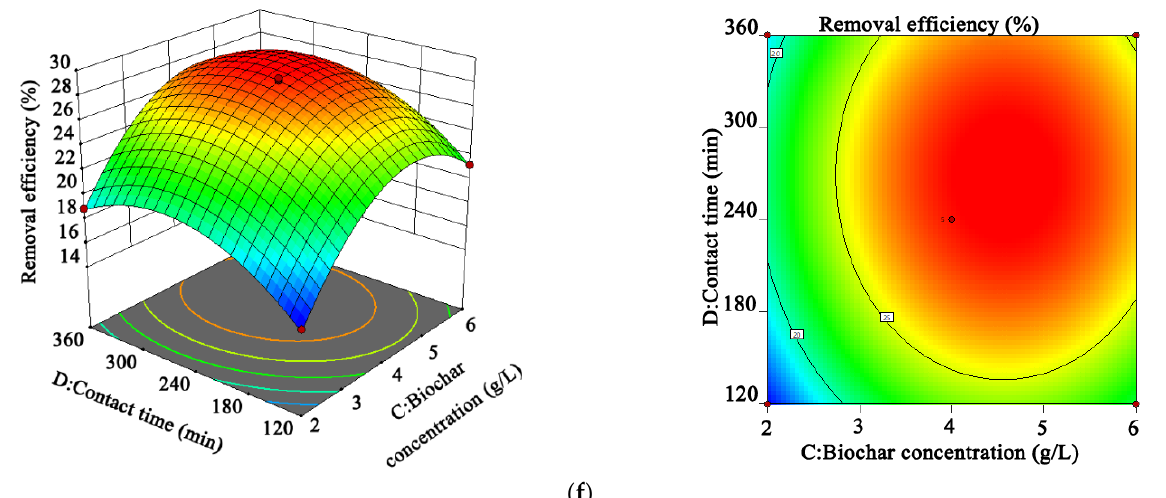
Figure 6. Contour plot and 3-D surface plot for Cr (VI) removal. ( a ) interaction between the Cr(VI) concentration and pH; ( b ) interaction between the Cr(VI) and biochar concentration; ( c ) interaction between Cr(VI) concentration and contact time; ( d ) interaction between pH and biochar concentration; ( e ) interaction between pH and contact time; ( f ) interaction between biochar concentration and contact time.